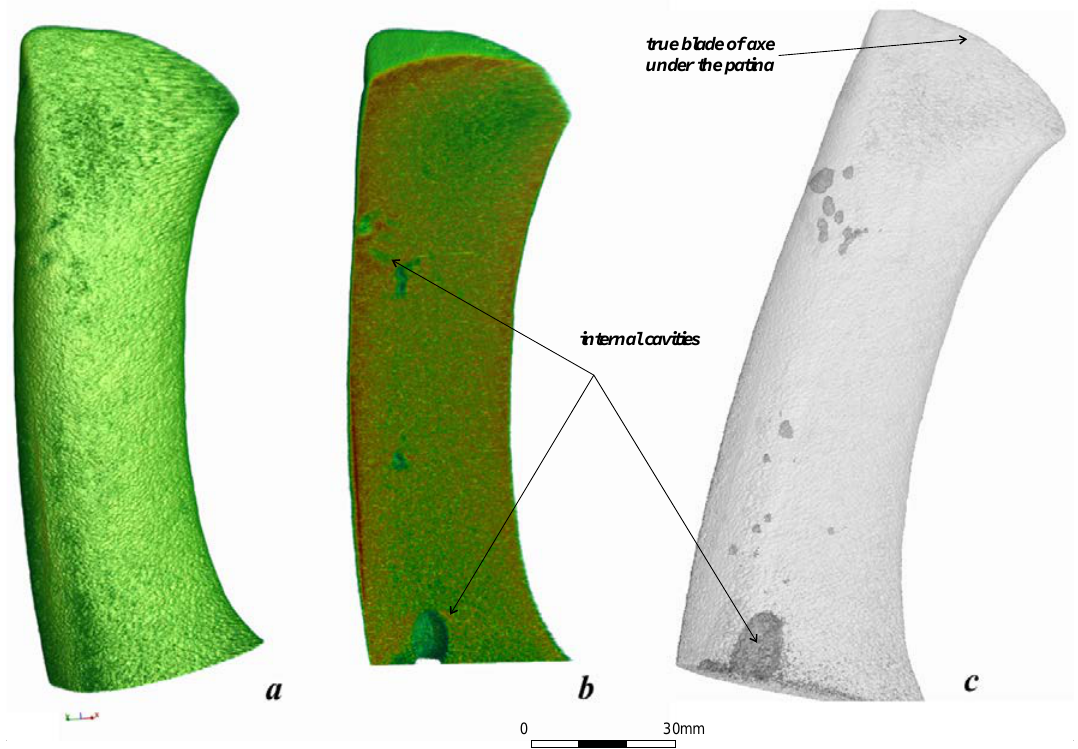
Figure 2. ( a ) 3D model of the bronze axe after tomographic reconstruction from neutron data. ( b ) Longitudinal virtual slice of the 3D model of the bronze battle axe. The inner voids and cavities are visible. The bottom large void is a manufacturing defect. The rainbow-like coloring shows the neutron absorption degree from low (blue) to high (red). ( c ) Transparent virtual model of the bronze battle axe with contrasting internal voids.